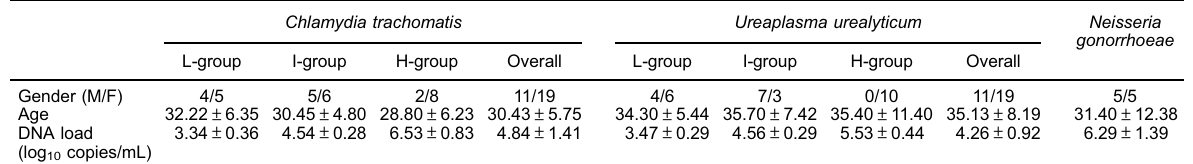
Table 1. Demographic characteristic of the study